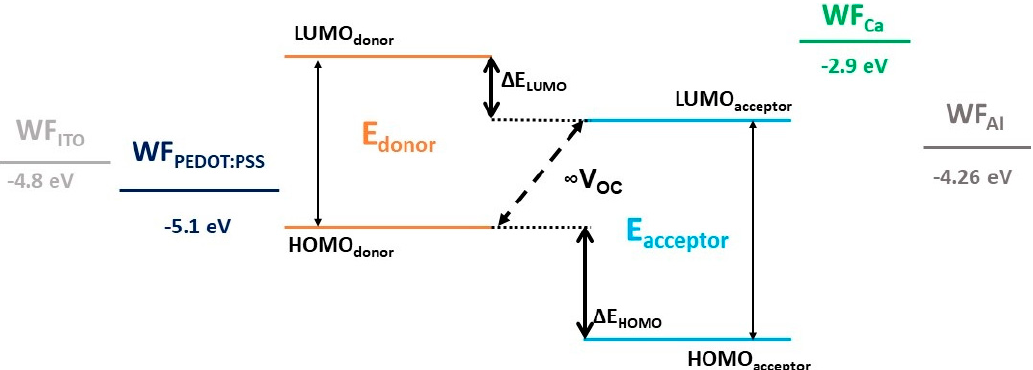
Figure 5. Diagram depicting the HOMO and LUMO energy levels of a donor and an acceptor pair. Also shown, the work function (WF) values of the ITO anode, the PEDOT:PSS HTL, the calcium electron transport layer (ETL), and the silver cathode.